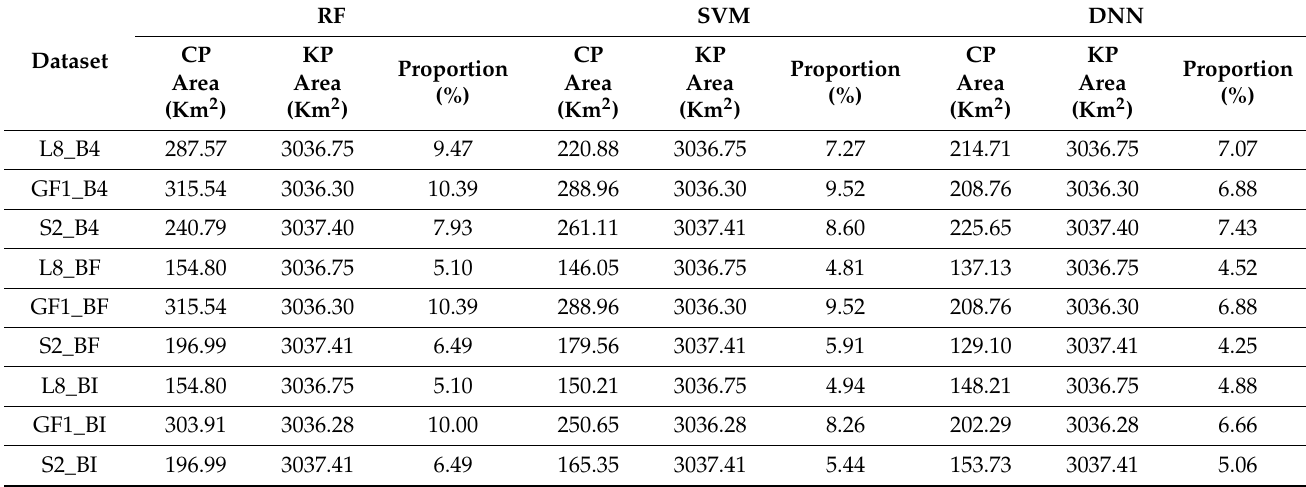
Table 4. Area of Chinese pine (CP) and Karaqin Banner (KB) calculated within the 27